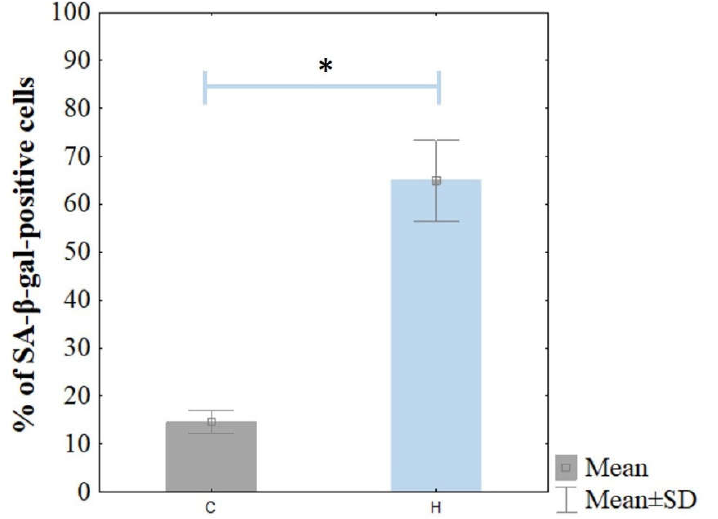
Figure 3. Percentage of SA-β-gal-positive cells in non-treated (C) and H 2 O 2 -treated ARPE-19 cells (H). The bars present mean ± standard deviation (SD); Student’s t-test; * p < 0.05. The percent of SA-β-gal-positive cells was counted in ten microscopic fields.